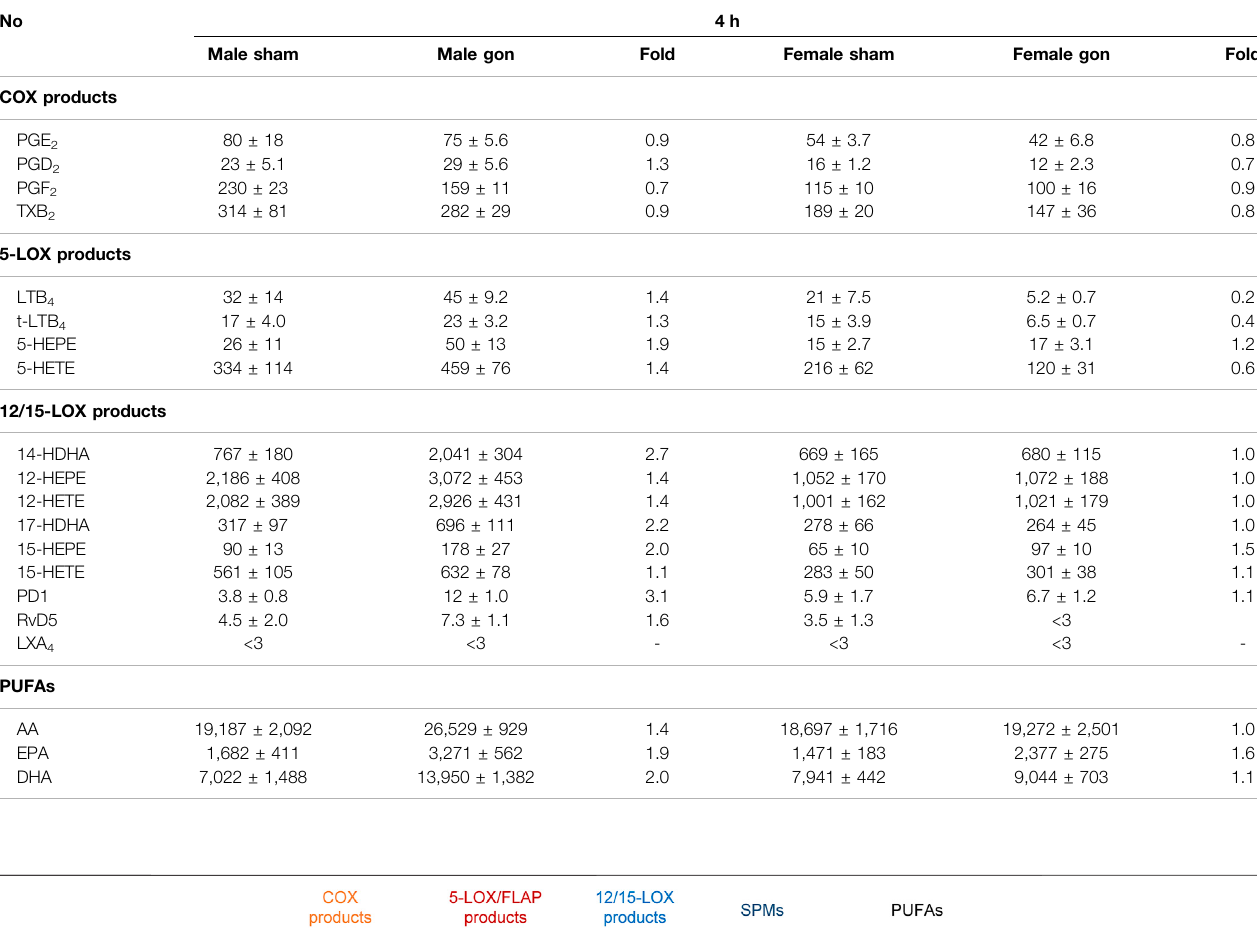
TABLE 3 | Effect of hormone depletion on lipid mediator pro fi les in peritoneal exudates from male and female mice at 24 h post-zymosan injection. Amounts of LM in peritoneal exudates from male and female mice 24 h post-zymosan/vehicle i.p. injection that underwent gonadectomy or sham-operation (see legend Figure 2 ). Data aregiveninpg/mLexudateexpressedasmean ± SEMofn (cid:1) 5to6animalspergroupandasheatmap.Fold-changeofgonadectomymeanvaluescomparedtoshammean values of male and female mice.